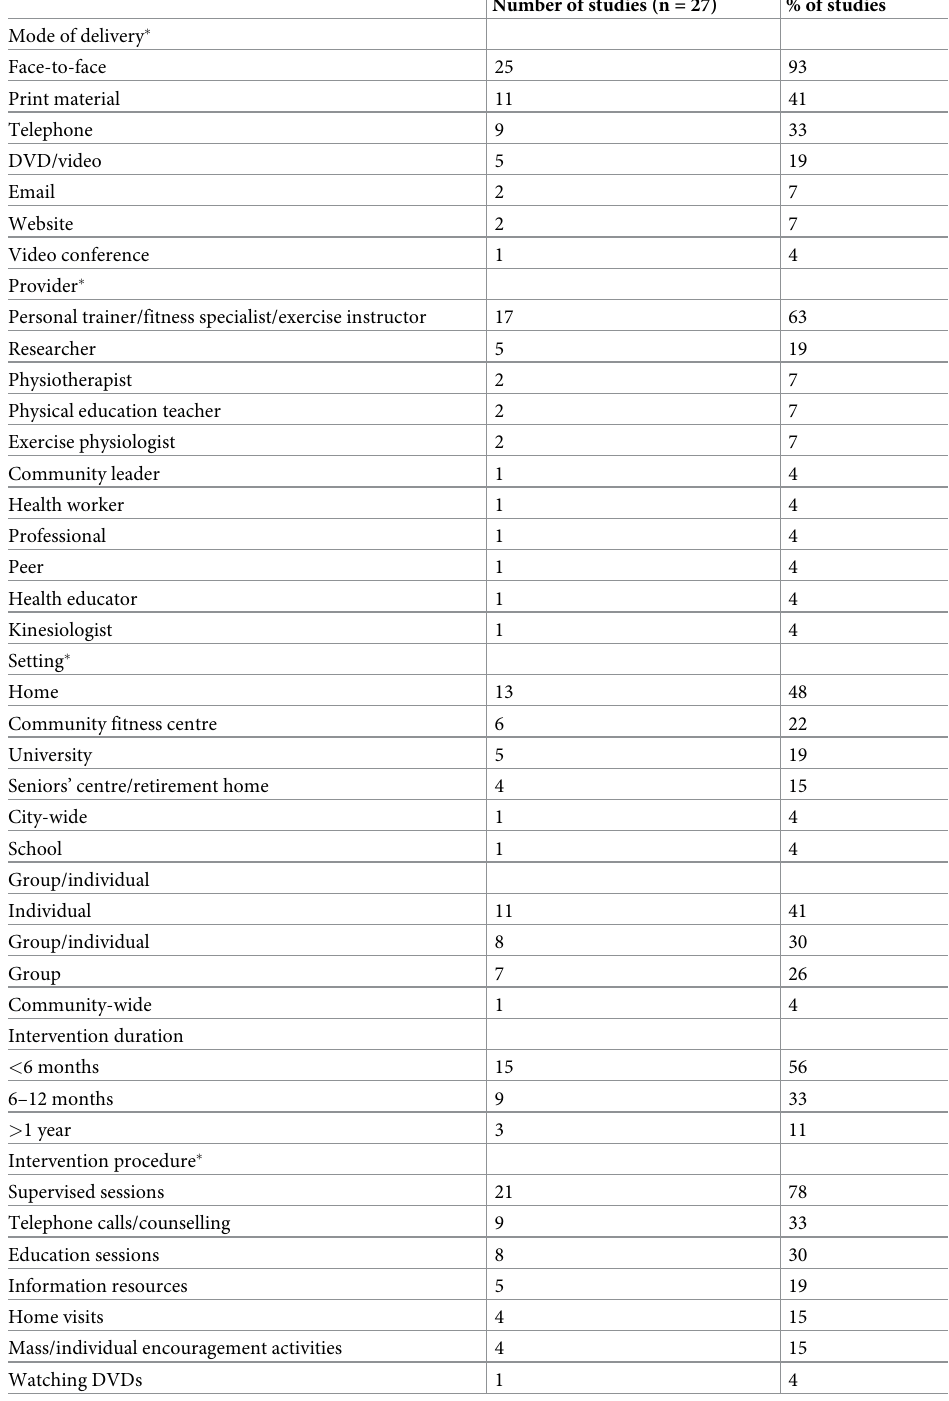
Table 2. Intervention